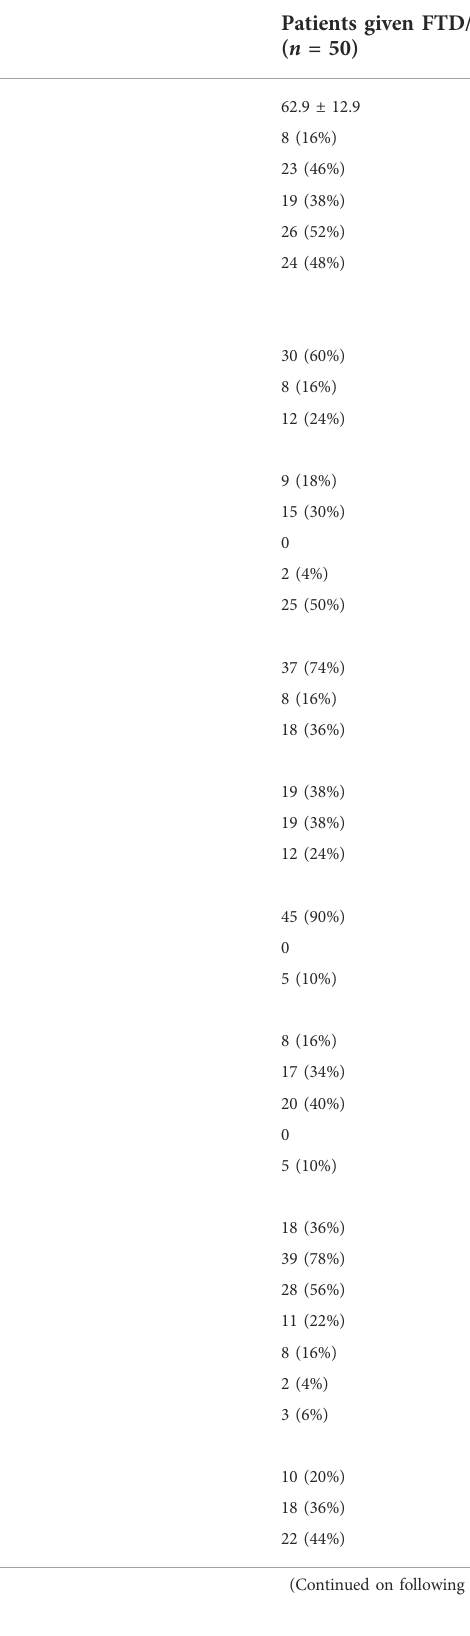
TABLE 1 Baseline patients ’